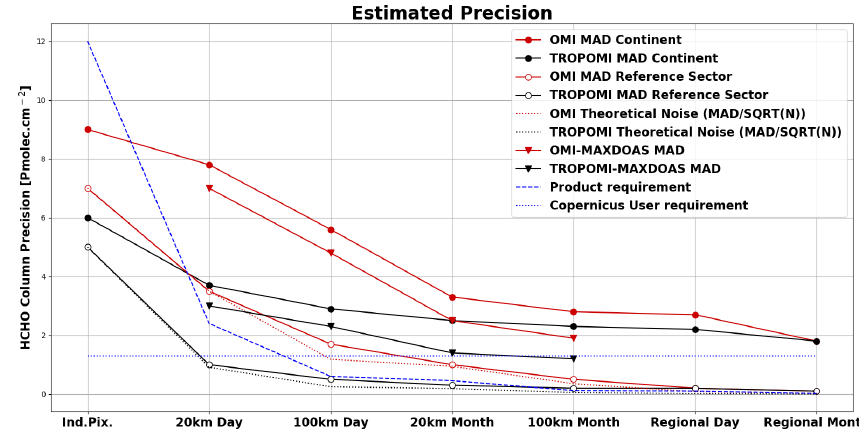
Figure 23. Estimated precision of OMI (in red) and TROPOMI (in black) HCHO columns at different spatial and temporal scales (20km, 100km, regions, day, month). The median deviation of the satellite HCHO columns are provided for continental emissions (plain cir- cles) and in the remote reference sector (white circles). Validation estimates are plotted at 20 and 100km (MAD of differences be- tween satellite and MAX-DOAS columns, triangles). The theoretical noise (dotted lines) corresponds to single-measurement precision divided by the square root of observations. The dashed blue line is the TROPOMI product requirement, based on a single-measurement precision of 12 × 10 15 molec.cm − 2 . The horizontal blue line at 1.3 × 10 15 molec.cm − 2 represents the Copernicus user requirement. (Pmolec.cm − 2 = 1 × 10 15 molec.cm − 2